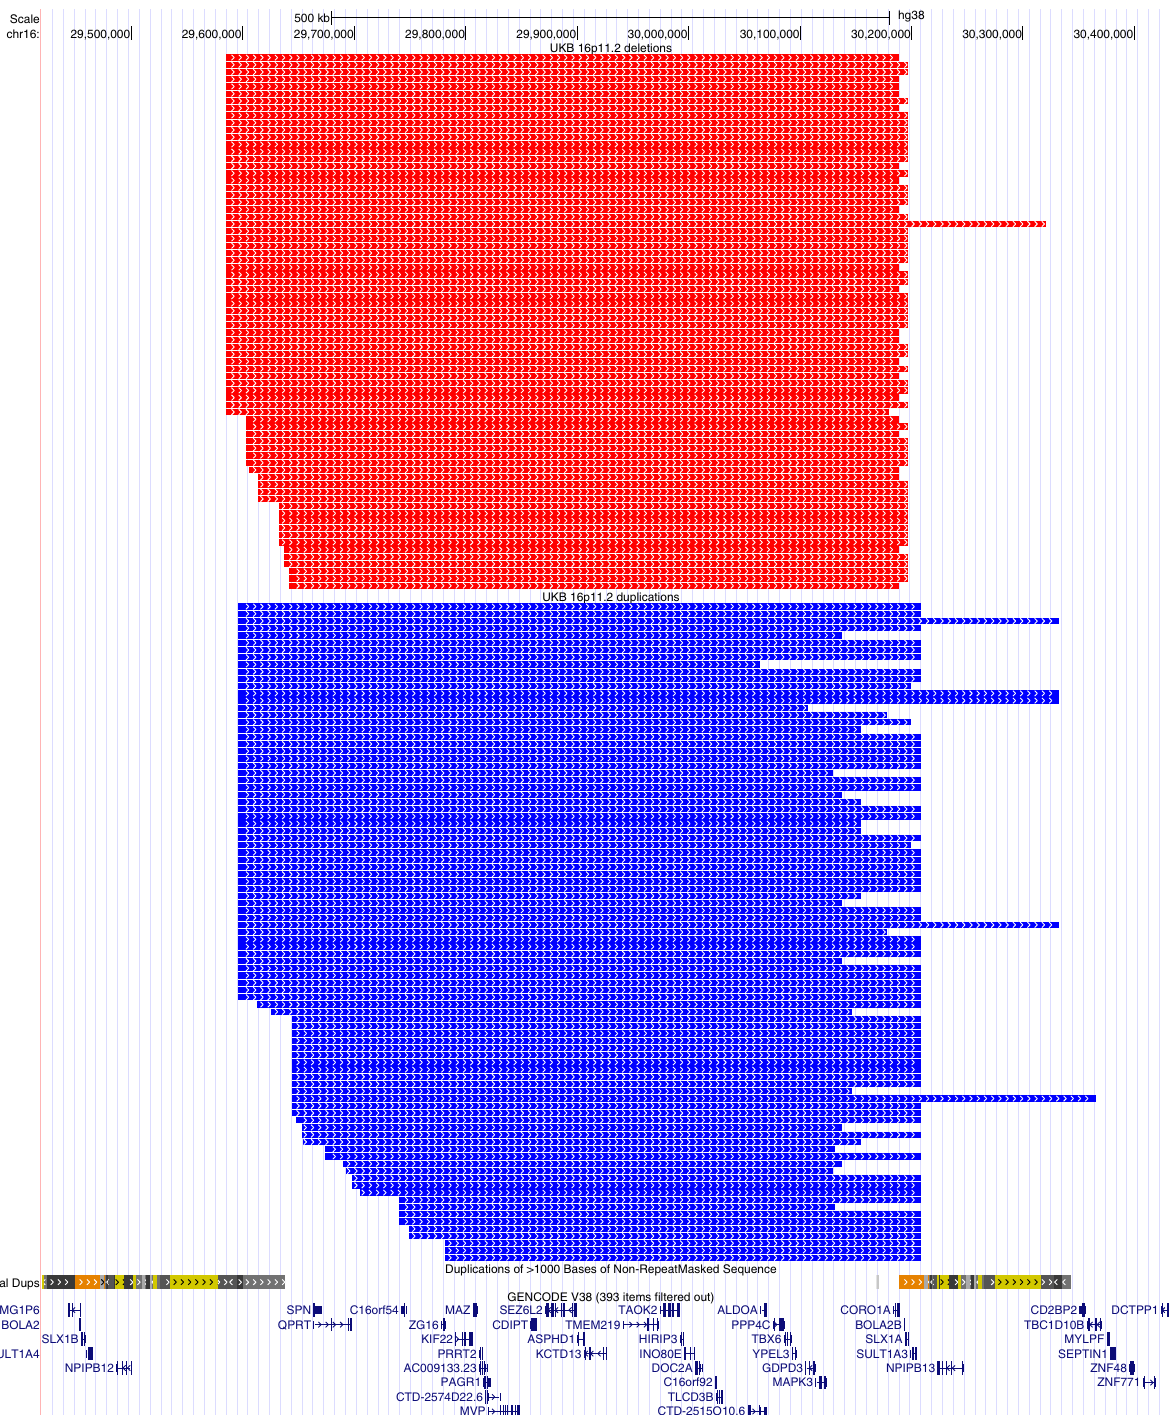
Fig. 3 UCSC genome browser view of 16p11.2 CNVs identi fi ed in individuals from UKB. The Segmental Dups and GENCODE Genes (protein-coding genes, version 38) tracks are shown. All deletions (red blocks) encompass the whole single-copy region (from SPN to CORO1A ) that is fl anked by segmental duplication clusters where there is uncertainty about the exact position of the breakpoints. As expected, breakpoints of duplications (blue blocks) are more variable, re fl ecting the greater dif fi culty in detecting duplications than deletions using SNP- array data 61 . However, because of the NAHR mechanism that generates CNVs at this locus, we would expect that all deletion and duplication breakpoints fall within the fl anking segmental duplication clusters (BP4 and BP5 hematological parameters in 41 mice of both sexes and all three As SLX1 , which maps to the human-speci fi c and copy-number genotypes (from 4 to 9 mice per condition). The age of mice at variant duplicon, might be associated with the low WBC count the time of assessment was within the range of 9 – 11 weeks. We in 16p11.2 deletion carriers, we analyzed the hematology of compared HET vs WT and HOM vs WT mice, by gender, and Slx1b haploinsuf fi cient and de fi cient mice. We measured 44